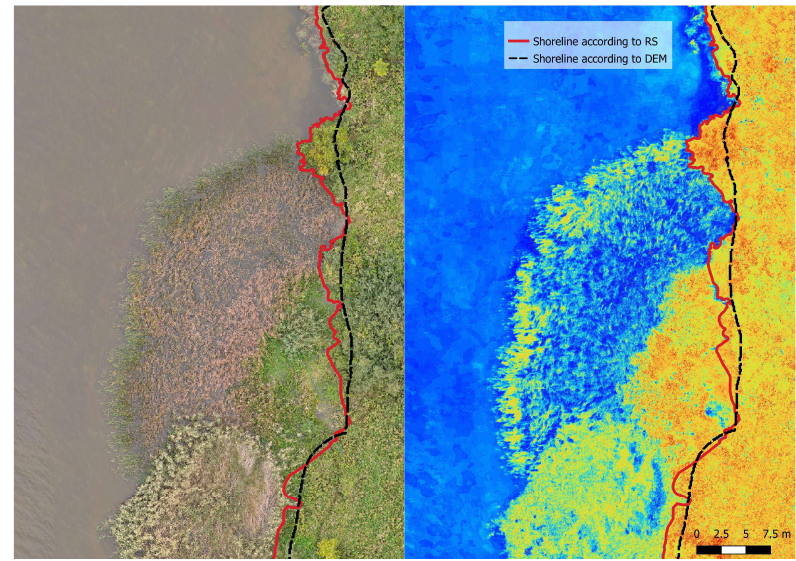
Figure 5. Shoreline detection in the areas containing medium-density aquatic vegetation.